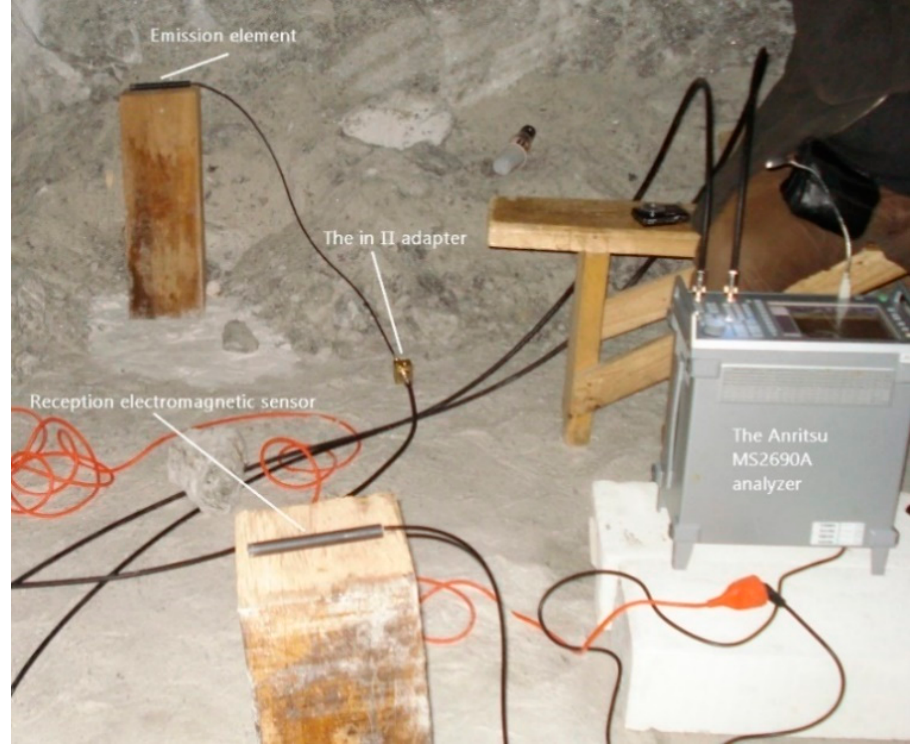
Figure 7. Air measurements.